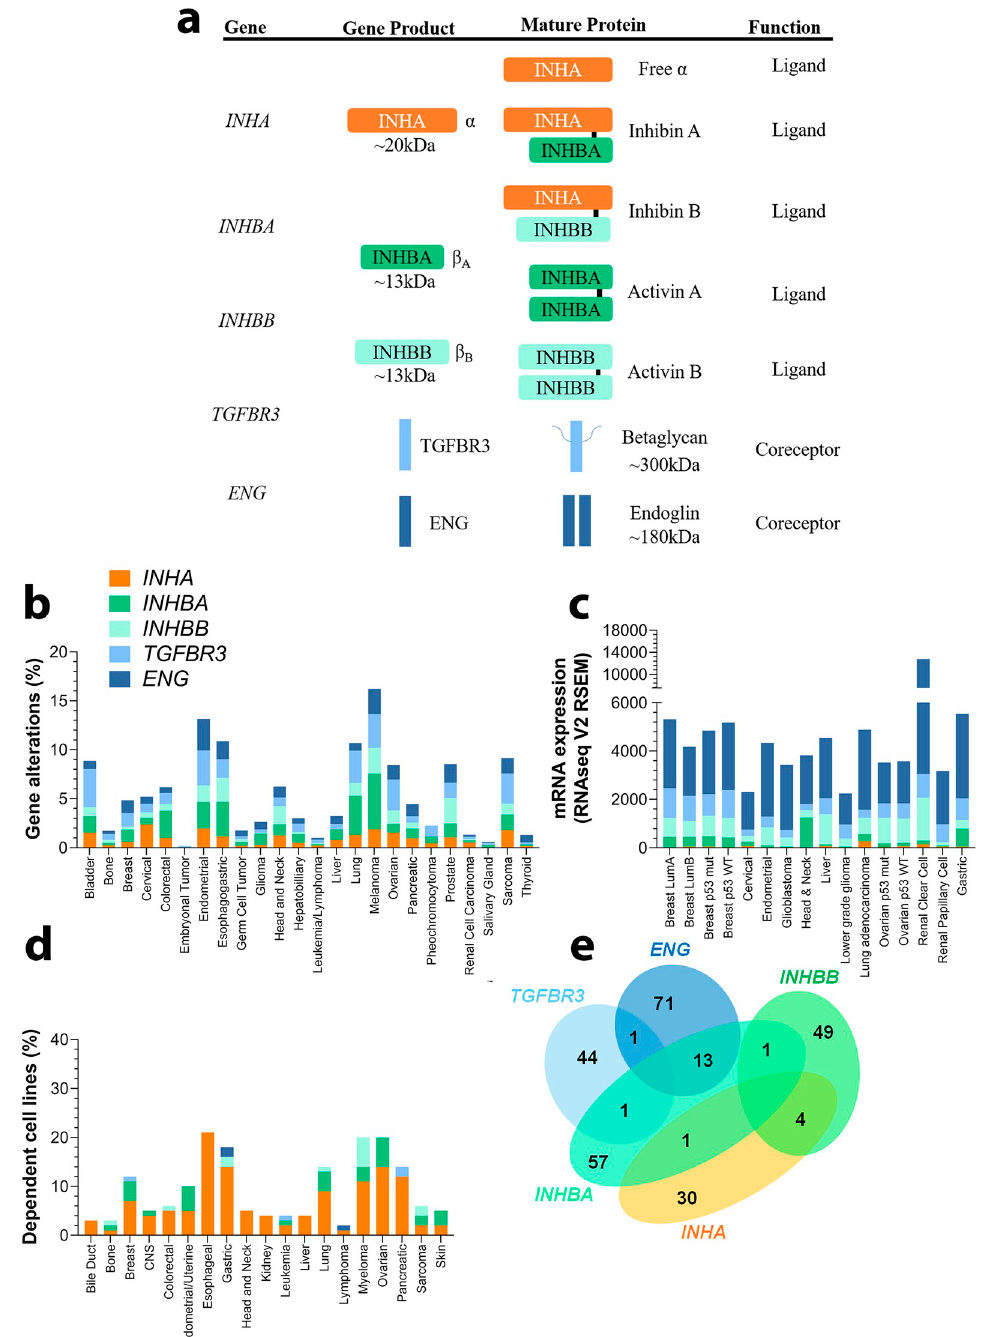
Fig 1. Expression and gene alterations of inhibin and activins. (a) Genes encoding INHA, INHBA, and INHBA produce monomeric α and β subunits. These subunits combine to form either homo or heterodimers representing mature inhibin A, inhibin B, activin A, and activin B. (b) TCGA base analysis of gene alteration frequencies of INHA , INHBA , INHBB , TGBFR3 , and ENG . (c) Analysis of gene expression levels, also from TCGA sets, of the same genes as in (b) in a subset of cancer types and subtypes. Analysis included 16 studies and 6258 samples. (d) DepMap analysis of cell line dependency from indicated cancer types on each of the genes in (b). (e) Venn diagram illustrating the number of common dependent genes for each gene in (b). All numeric data are available in S1 Table. Abbreviations—CNS: Central Nervous System; LumA: Luminal A; LumB: Luminal B; mut: mutated; WT: wild-type.